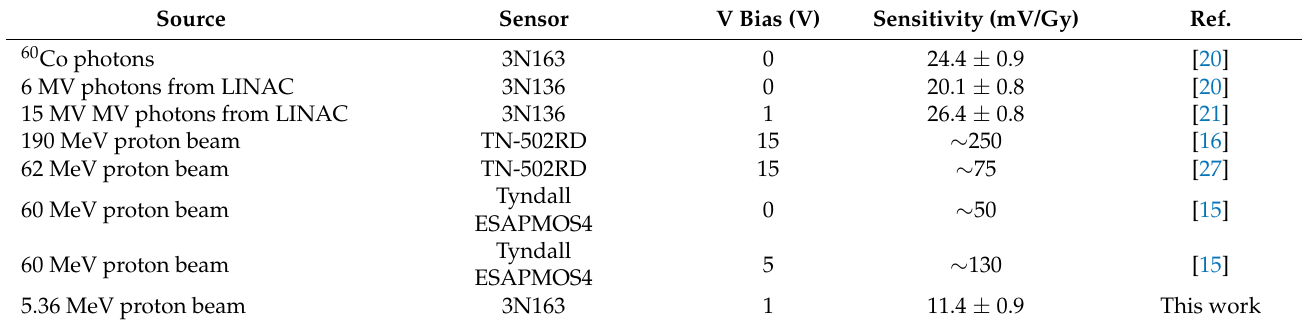
Table 3. Response of different MOSFET used as proton